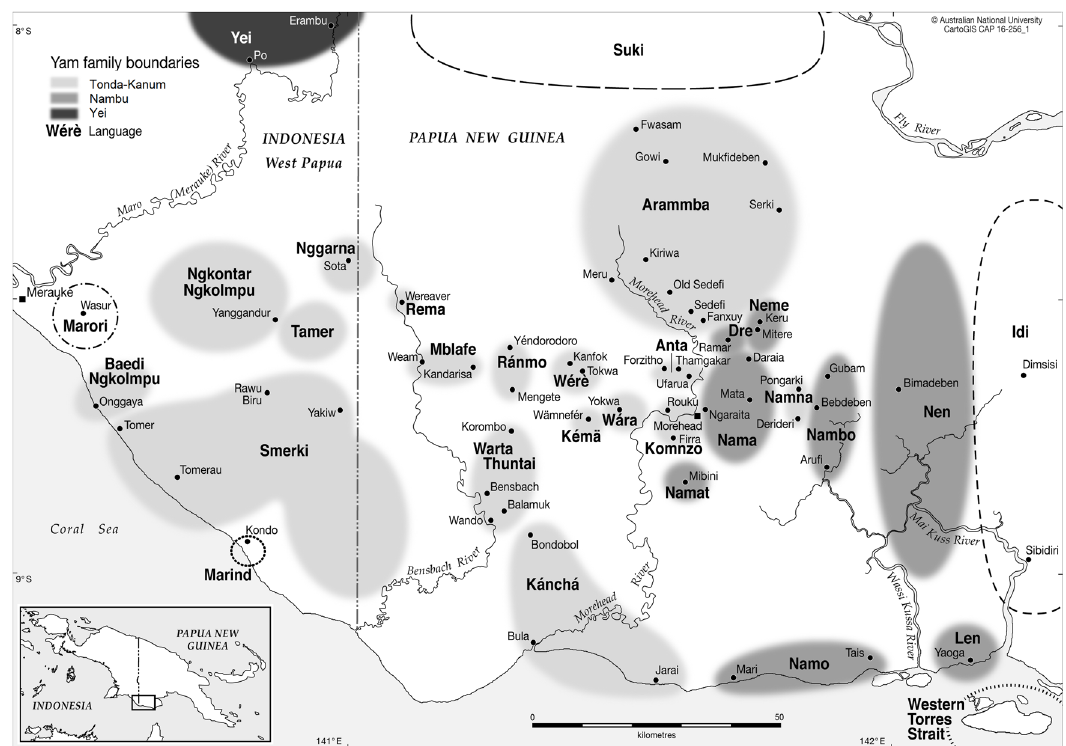
Figure 1: The Yam language